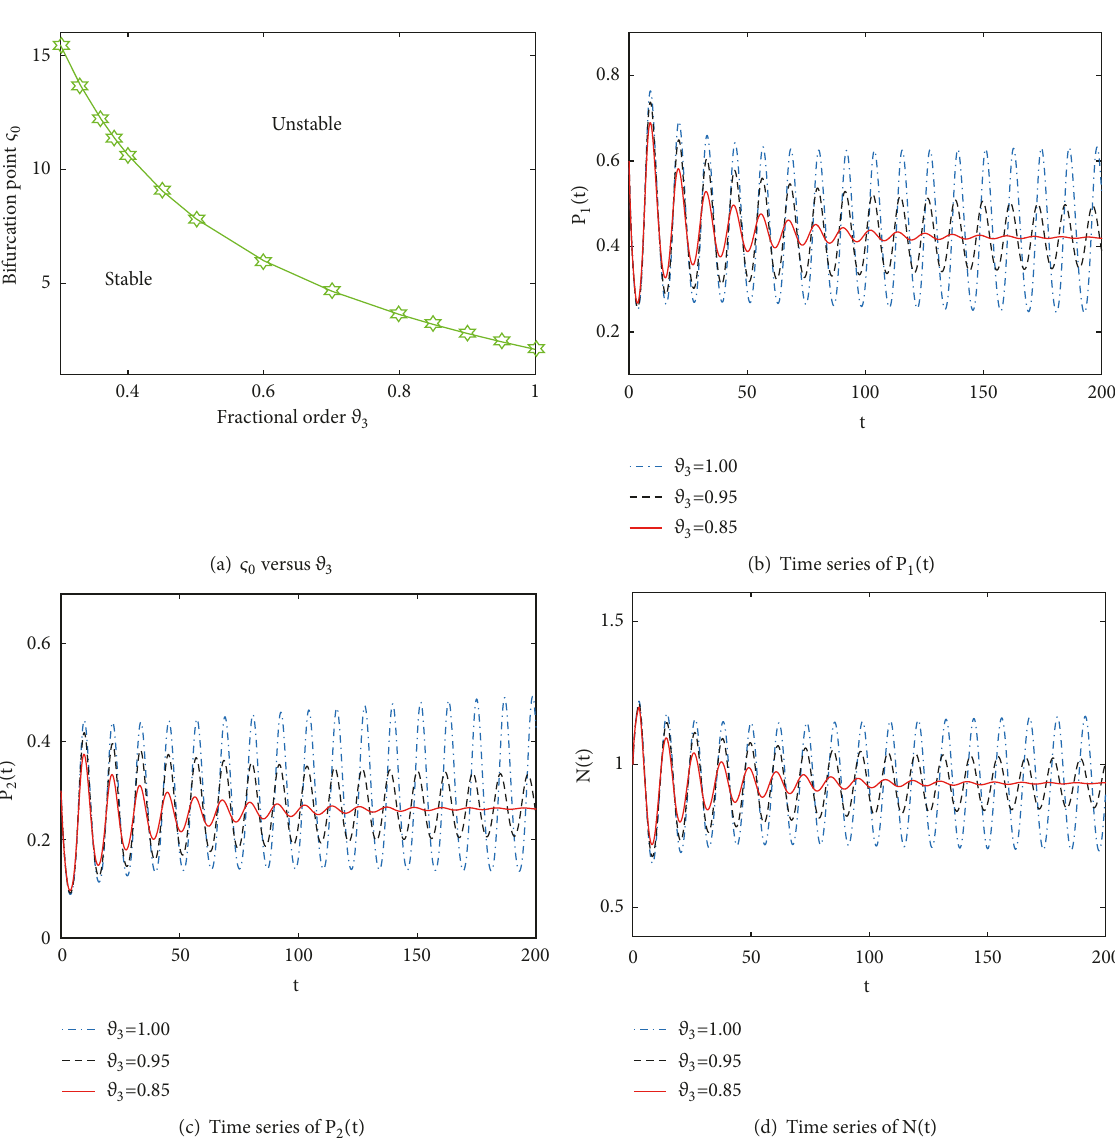
Figure 7: The effects of 𝜗 3 on the dynamical behaviors with 𝜗 1 = 0.85 and 𝜗 2 = 0.90 . Bifurcation value 𝜍 0 is negatively correlated with 𝜗 3 which is shown in (a) and numerical simulation validates the theoretical results which is shown in